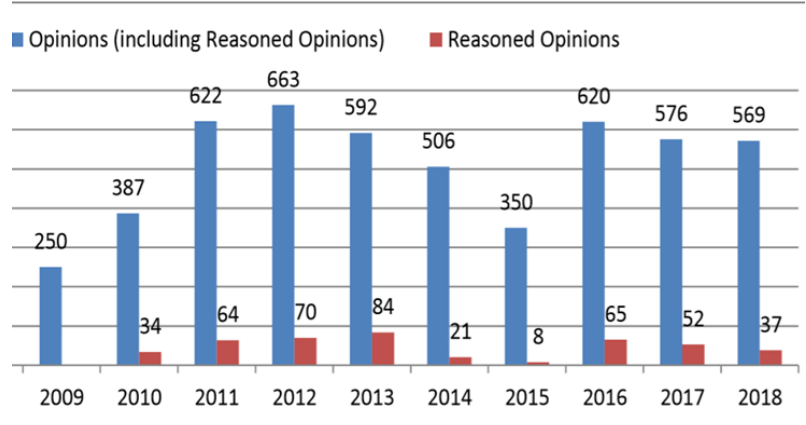
Figure 1. Overview of the number of reasoned opinions (ROs) compared to other opinions since 2009. Source: European Commission (2019, p. 16).